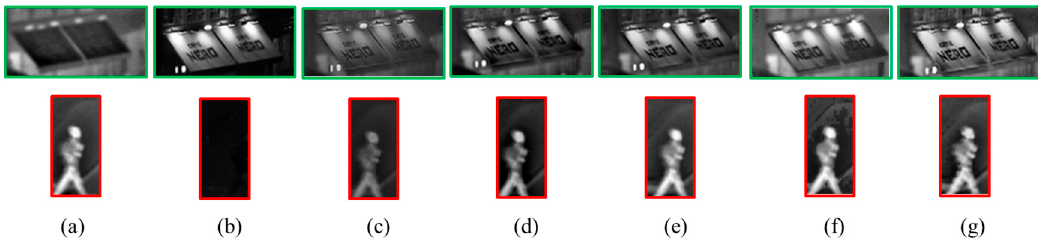
Figure 7. Fusion detail comparisons: ( a ) IR image; ( b ) Visible image; ( c ) DWT [12]; ( d ) PCA-MST [22]; ( e ) GFF [24]; ( f ) IHS-PCNN [23]; ( g ) The proposed method.